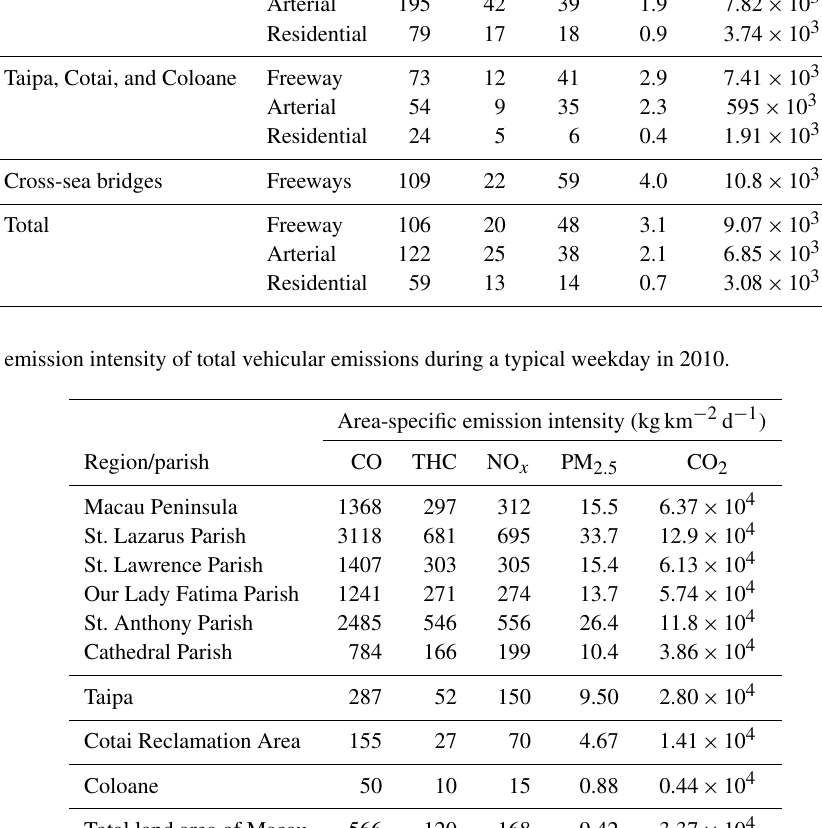
Our Lady Fatima